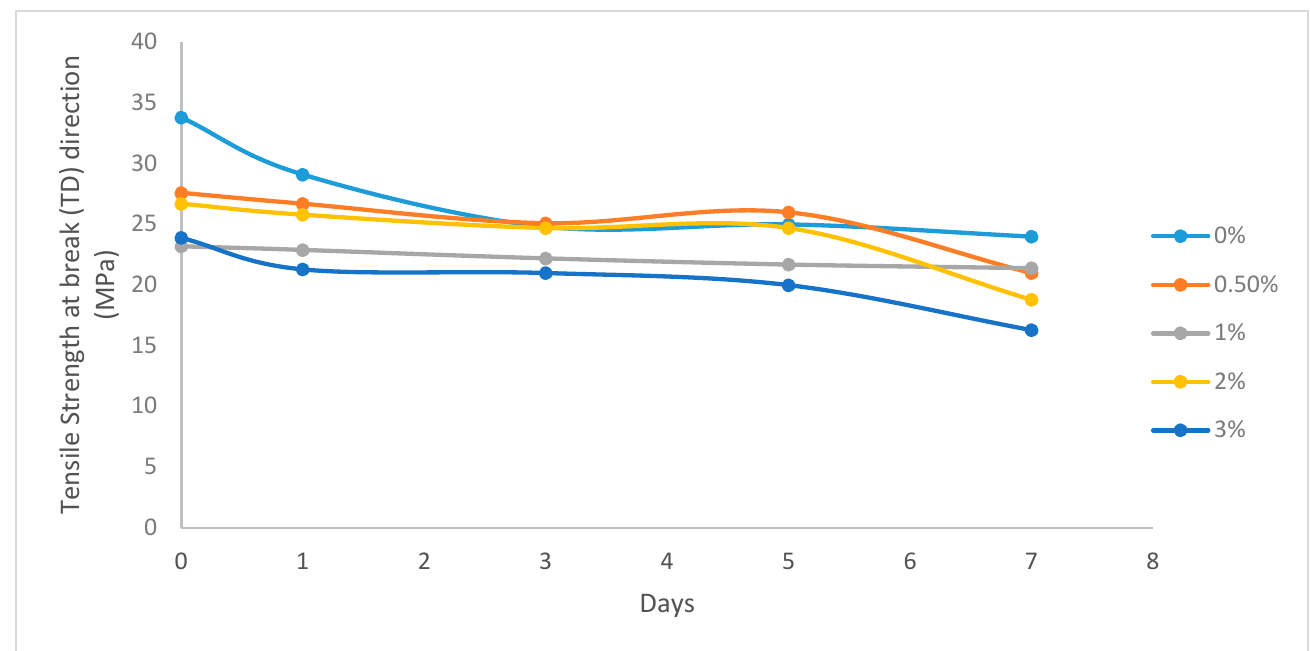
Figure 2. Changes in the tensile strength at break in transverse direction (TD).